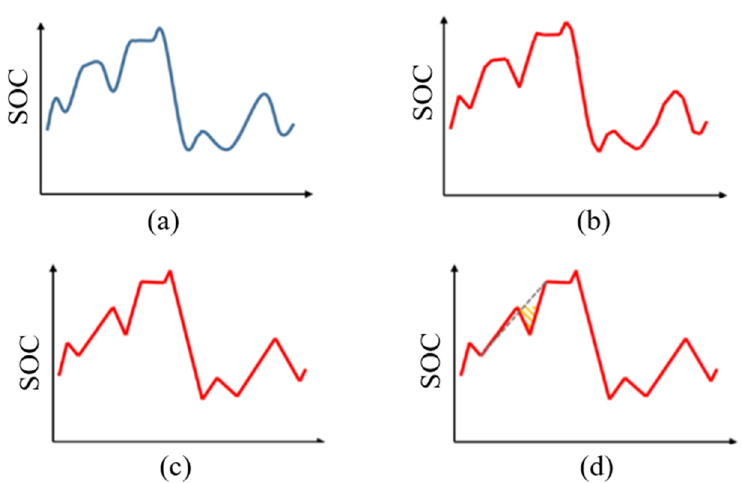
Figure 8. A schematic diagram for aging feature extraction.